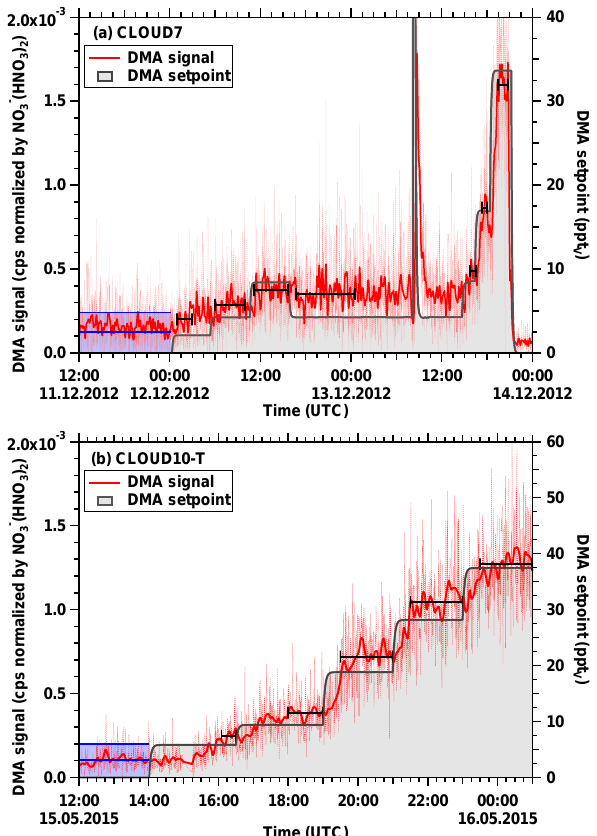
Figure 4. Time series of the normalized cluster ion signal indicat- ing the DMA concentration with 10min resolution (red lines) and 30s time resolution (light red line) during the CLOUD7 (a) and CLOUD10-T (b) calibration. The grey lines and areas indicate the targeted DMA mixing ratios due to the MFC setting for the gas system. The average background signals including the 3 σ standard deviation are shown by the horizontal blue lines and the light blue bands. The black lines illustrate the averaged periods. At the end of the displayed period in panel A the instrument was disconnected from the chamber and pure nitrogen was sampled; therefore the DMA signal drops immediately while DMA was still added in the chamber.